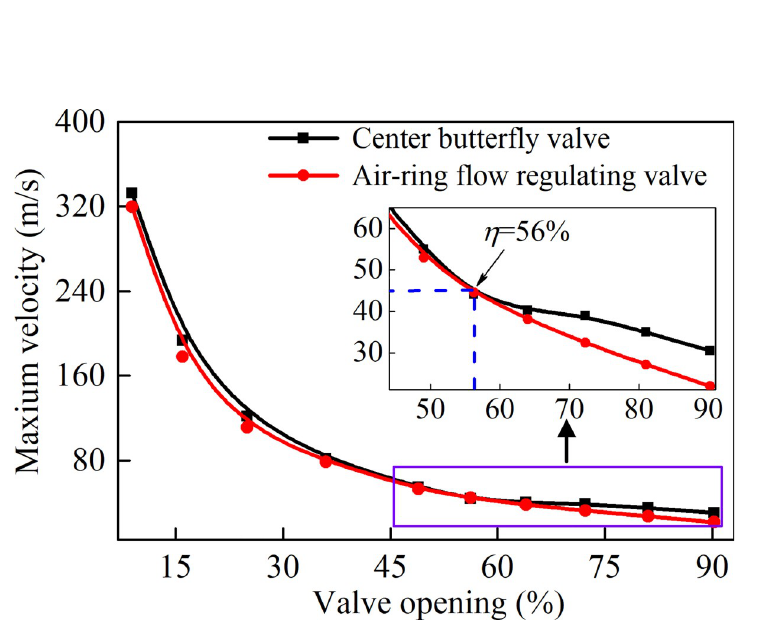
Fig 13. Maximum velocity of both valves at different valve openings in flow fields.